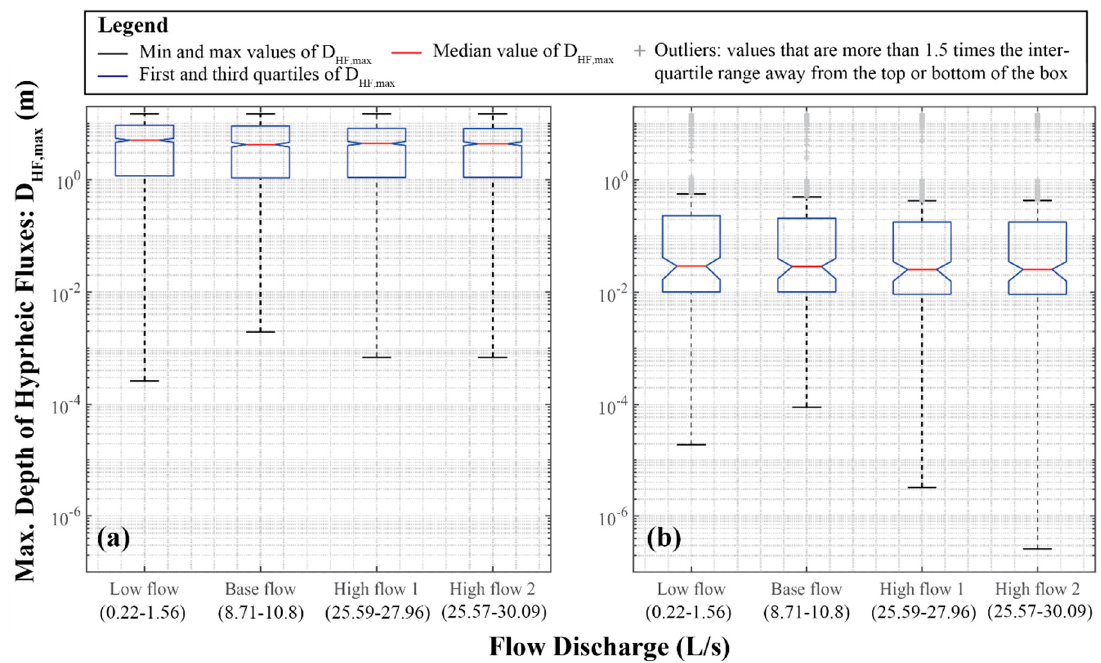
Figure 5. Boxplots showing the maximum depth of hyporheic fluxes under various flow discharges assuming ( a ) constant intrinsic permeability ( k = 10 − 9 [m 2 ]) for the entire subsurface region and ( b ) a decaying intrinsic permeability (starting from k ( z = 0) = 10 − 9 [m 2 ] at the surface–subsurface water interface and decaying exponentially to k ( z = − 1) = 10 − 12 [m 2 ] at one meter depth). In the case of a vertically varying permeability, a constant permeability ( k = 10 − 12 ) was used for depths larger than one meter. The second row of the horizontal axis (i.e., numbers), are the ranges of stream flow discharge along the stream for each flow regime. D HF,max : deepest point of the streamlines.